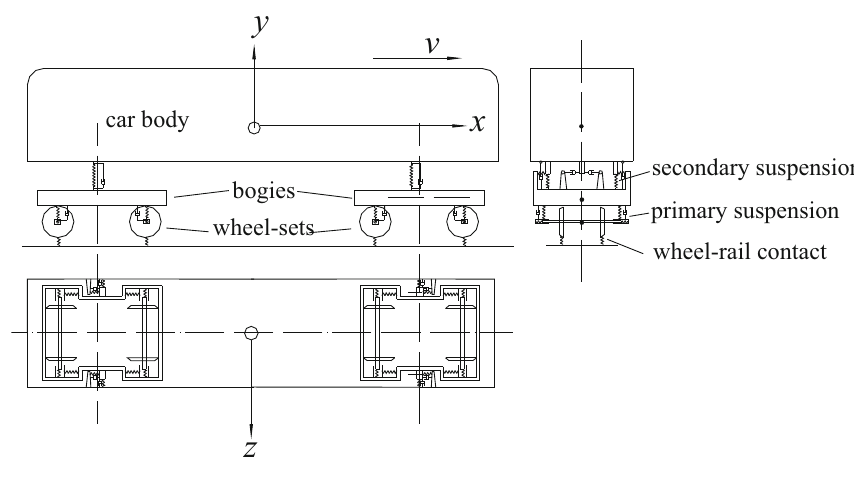
Fig. 2 Schematic model of a railway